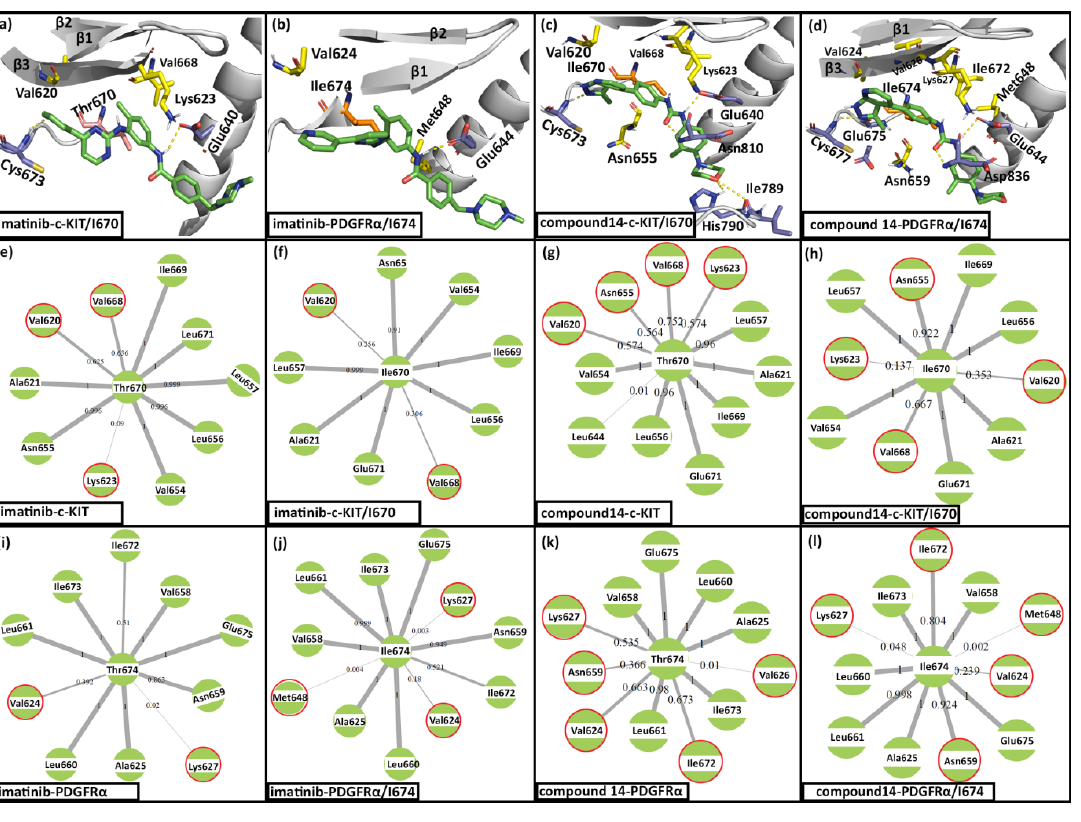
Figure 4. H-bond interactions and residue contact map from the MD simulation of imatinib and compound 14 . Proteins are shown in grey color cartoon representation and inhibitors are shown green color stick representation. H-bonds are shown in yellow dotted lines. Residues forming H-bond interactions are shown in purple color stick representation. Substituted residues and the residues forming interactions are shown in salmon color and yellow color stick representations respectively.